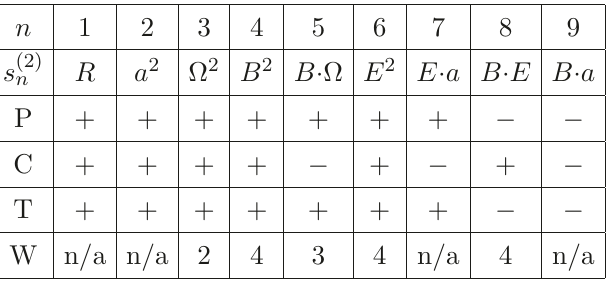
Table 1 . Independent O ( ∂ 2 ) equilibrium invariants in 3+1 dimensions. The rows labeled P, C, T indicate the eigenvalue of the corresponding invariant under parity, charge conjugation, and time- reversal, respectively. The row labeled W indicates the conformal weight w of the corresponding invariant. The invariants labeled “n/a” do not transform homogeneously under the Weyl rescaling of the metric. The first invariant is the Ricci scalar, the other invariants are formed out of the vectors defined in the